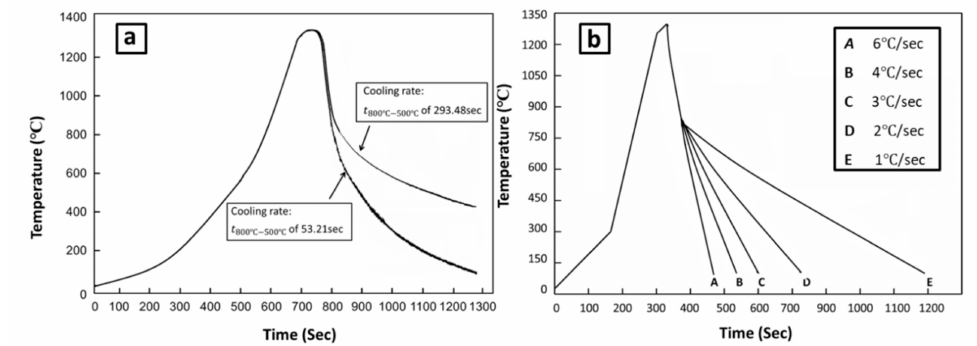
Figure 1. Thermal cycles in the coarse-grained heat a ff ected zone (CGHAZ) of electroslag welded pearlitic rail steel. ( a ) Measured thermal cycles. ( b ) Thermal cycles achieved during confocal scanning laser microcopy (CSLM) and Gleeble simulation.